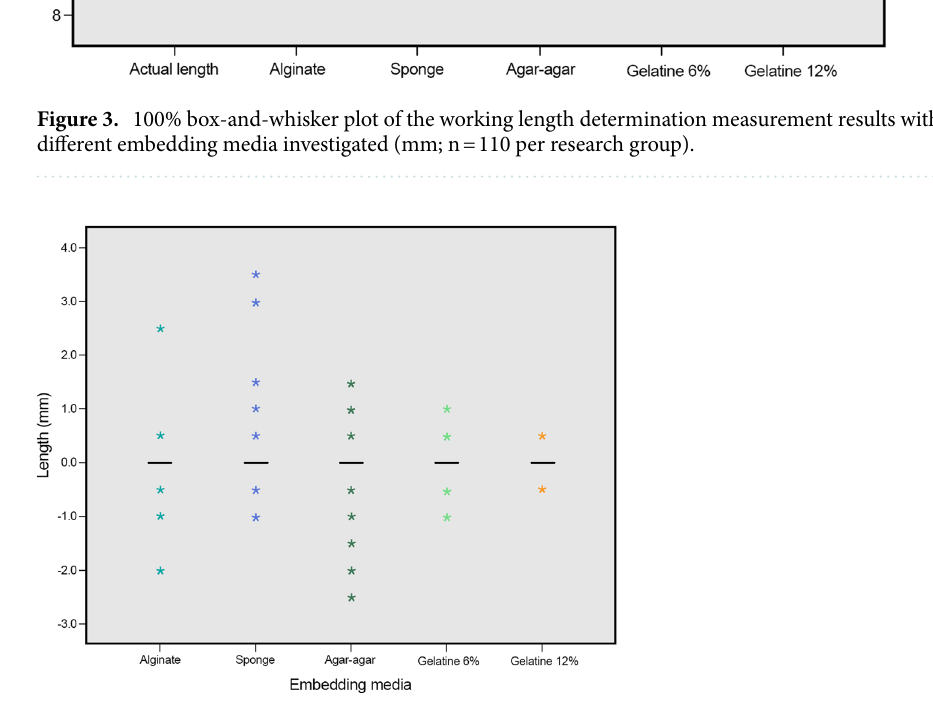
Figure 4. Box plot showing the differences distribution between the actual working length (0.0) and the ones obtained with the different embedding media. The lines at “0.0” represent the 25th quartile, median and 75th quartile. Consequently, a characteristic box cannot be seen in the present figure. A slight tendency of too long and too short measurements for sponge and agar–agar, respectively, can be observed. For alginate and gelatin in both concentrations the scattering is similar (mm; n = 110 per research